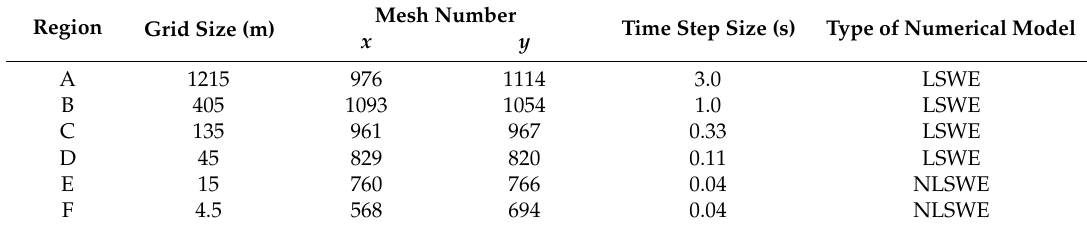
Table 3. Computational mesh details.